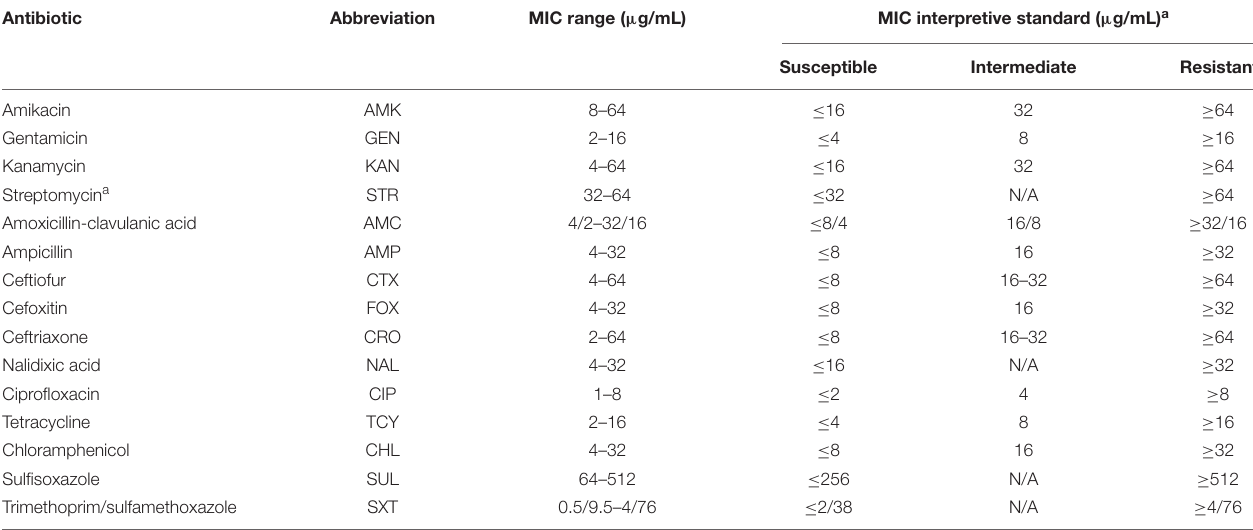
TABLE 2 | The minimum inhibitory concentration (MIC) ranges and breakpoints of 15 antibiotics used in the study. Antibiotic